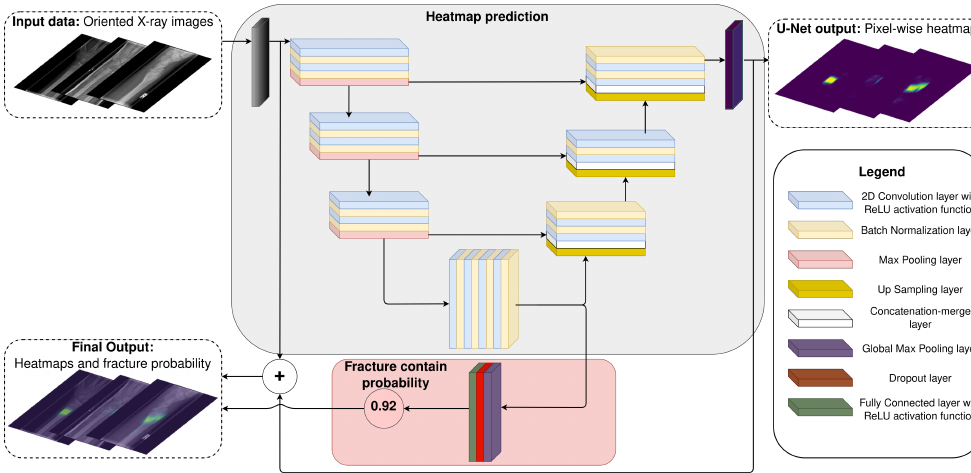
Figure 1. An illustration of the utilised U-Net NN model topology, inspired by